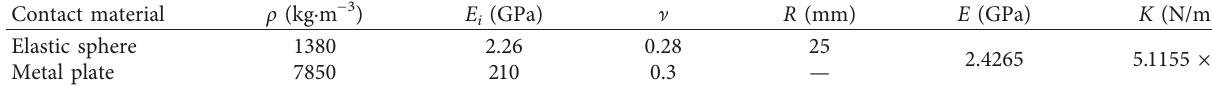
Table 1: Parameters of contact model of the elastic sphere and metal plate.